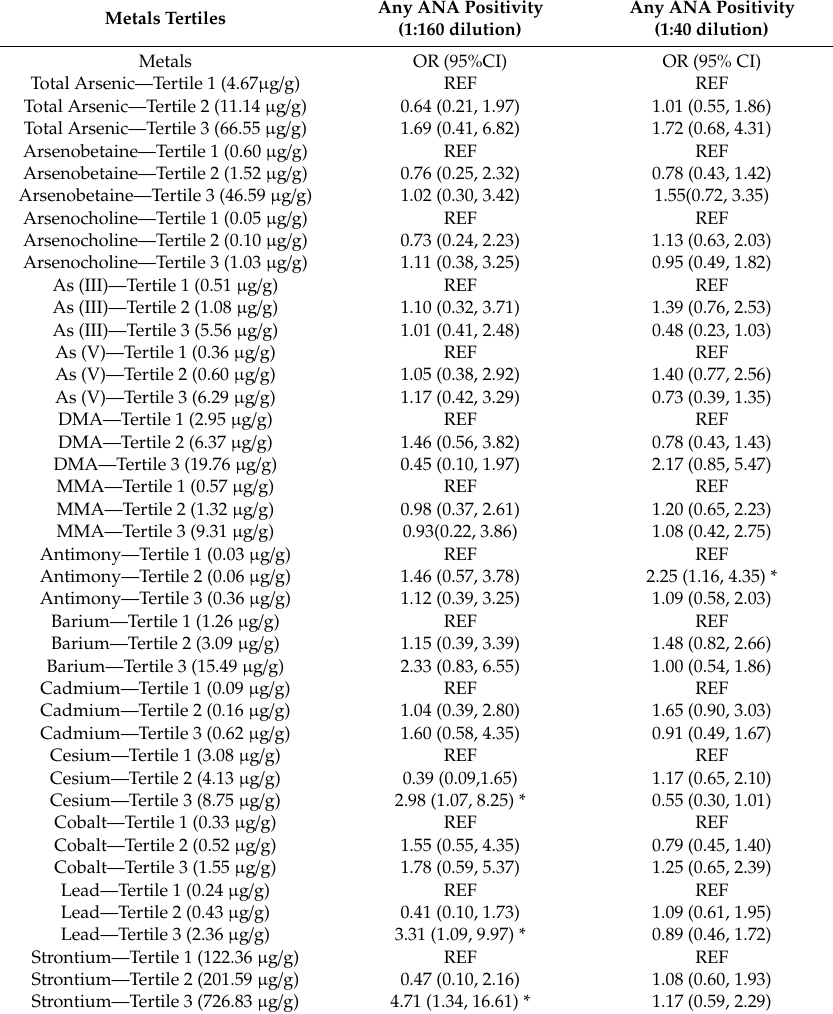
Table 3. Multivariable logistic regression results: Odds of association between urinary metals concentrations ( µ g / g creatinine) by tertile with first tertile as reference (REF) and any ANA positivity ( ≥ 2 + ) at cellular